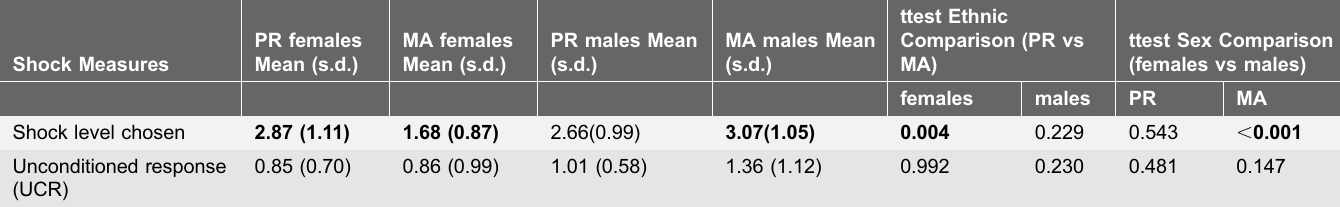
Table 2. Shock level chosen and Unconditioned response of sample divided by sex and site with ttest comparison between PR and MA (ethnic) and between females and males (sex) at each site. PR females MA females PR males Mean MA males Mean Shock Measures Mean (s.d.) Mean (s.d.) (s.d.)